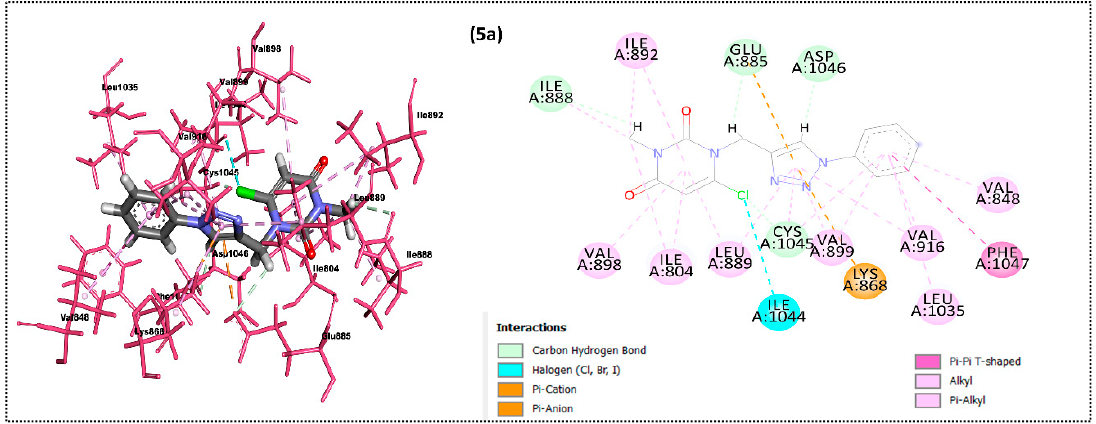
Figure 4. Docking interactions (3D & 2D) of 5a with the receptor protein, VEGFR-2 transferase. Critical amino acid residues are shown in the stick model and pink colour.